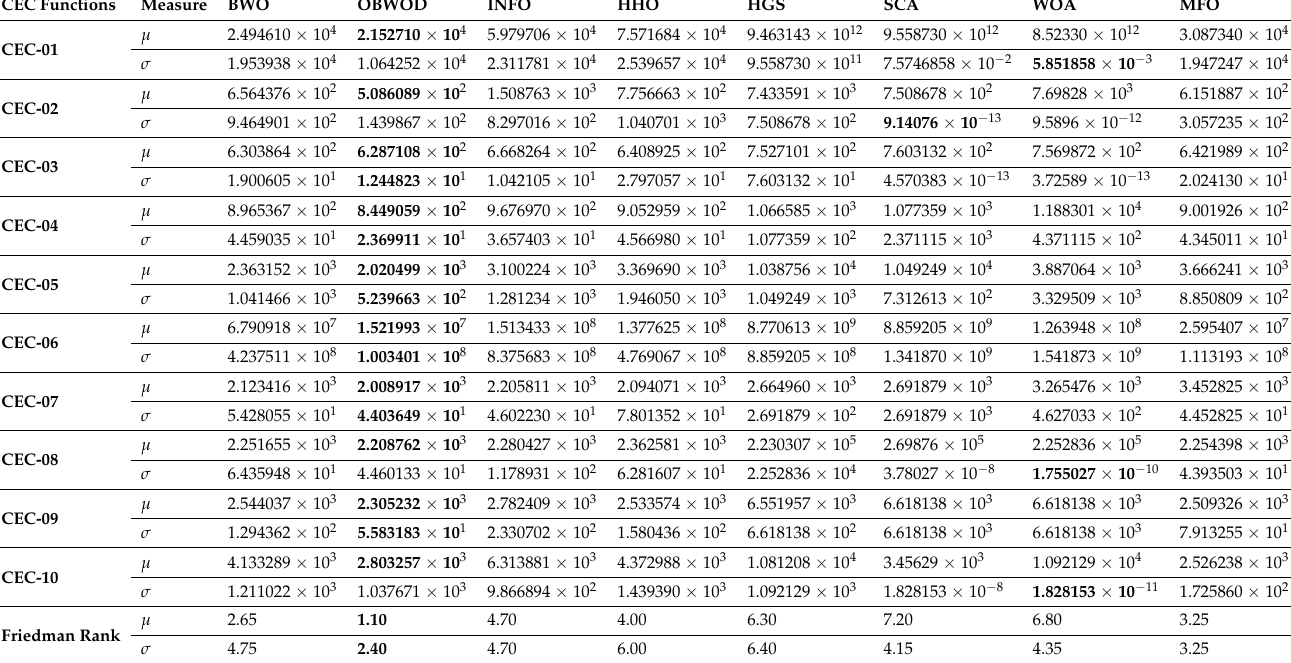
Table 6. Comparison of the CEC’22 between OBWOD and other optimization algorithms based on the kNN